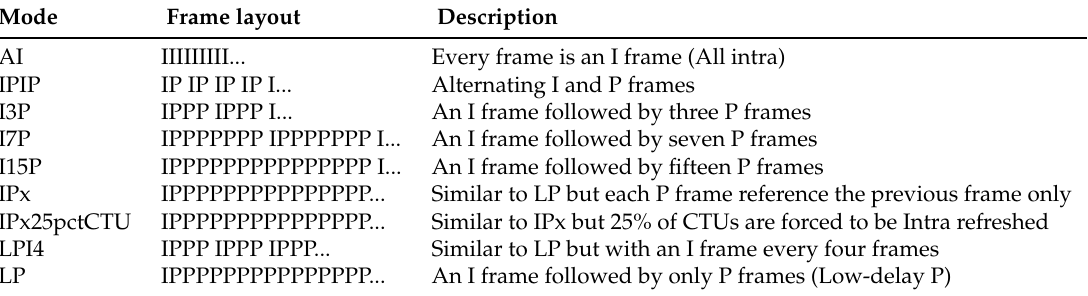
Table 4. Encoding modes.